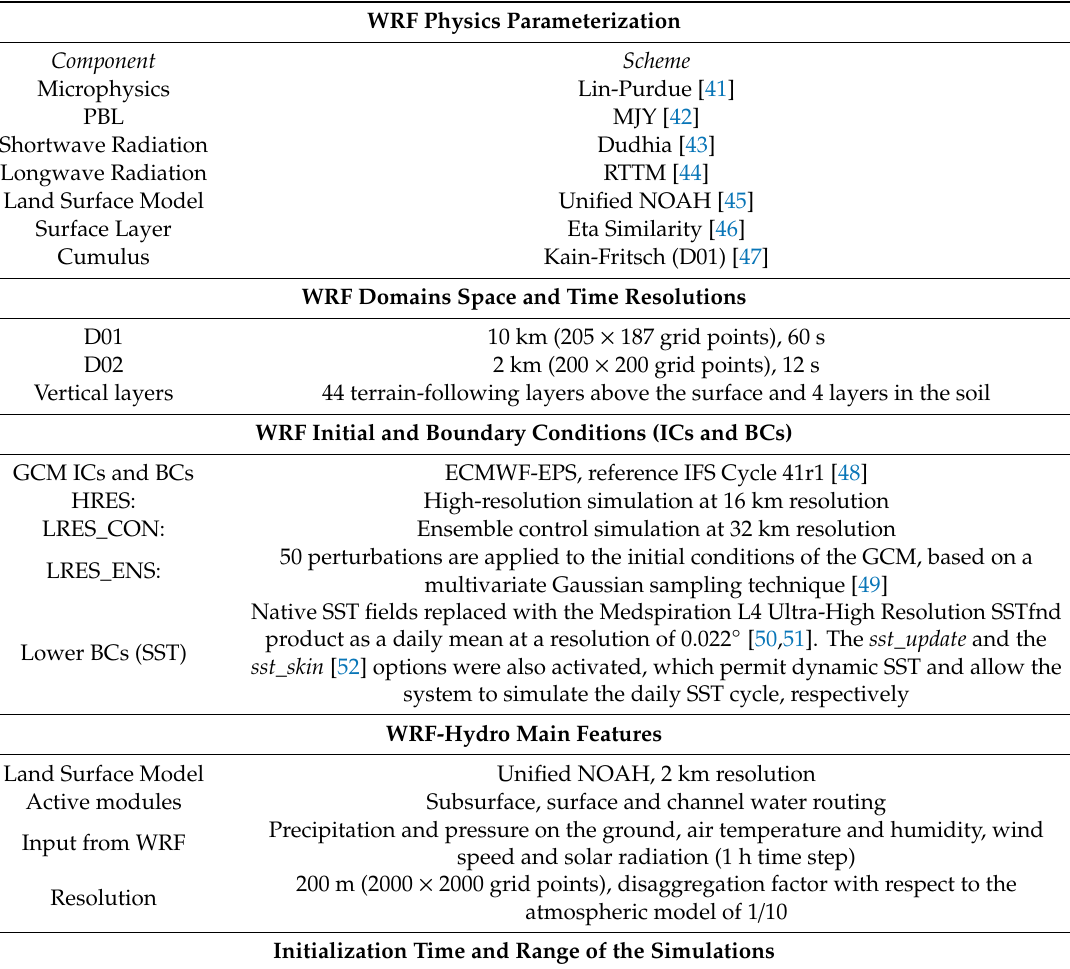
Table 1. Main features of the simulations performed in this